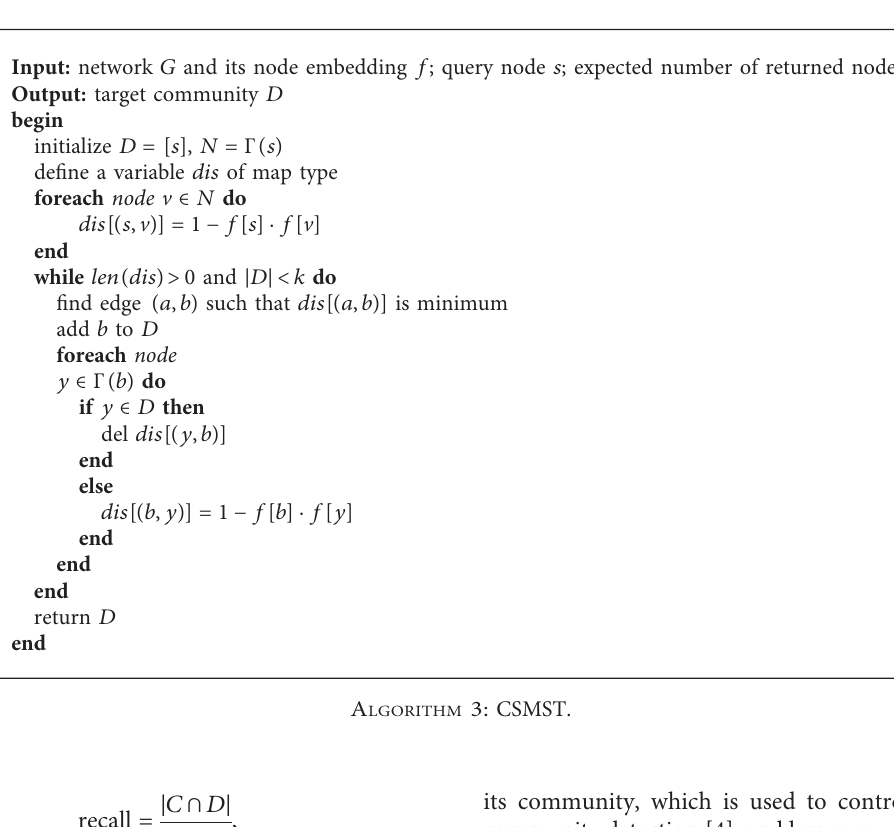
Figure 3: An example of the improved Prim algorithm. (a) Graph G and a query node s . (b) A minimum spanning tree H in G with 8 nodes starting from s